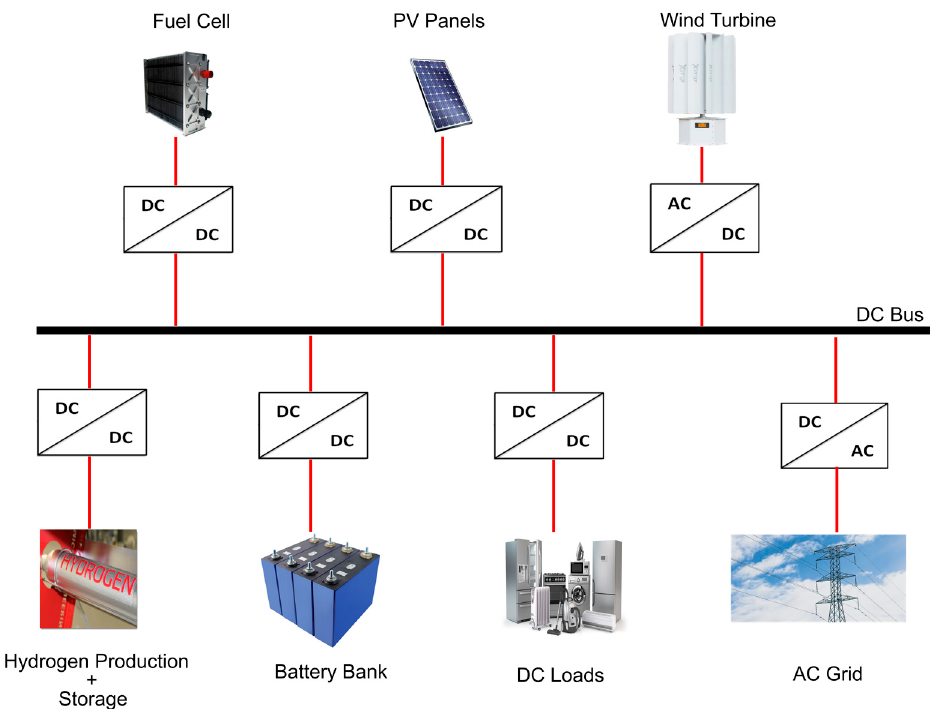
Figure 1. Example of a DC microgrid’s structure.